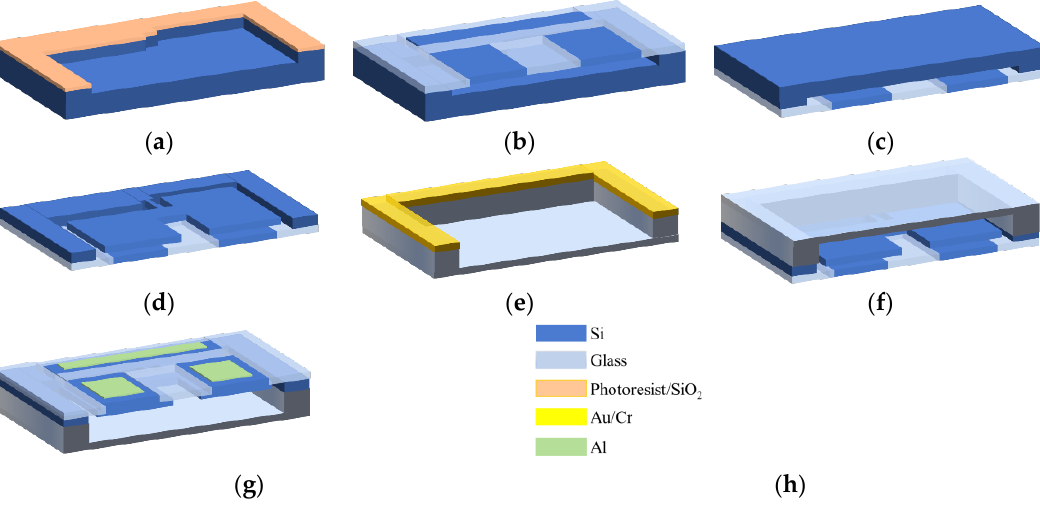
Figure 5. Preparation process of the teeter-totter accelerometer. ( a ) Si etching; ( b ) anodic alignment bonding; ( c ) CMP; ( d ) structure etching; ( e ) wet etching; ( f ) anodic alignment bonding; ( g ) the electrode preparation; ( h ) legends.